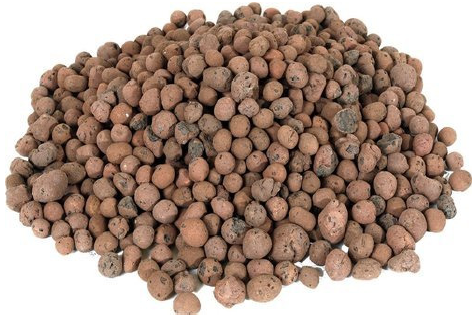
Figure 3. LECA as the coarse aggregate.